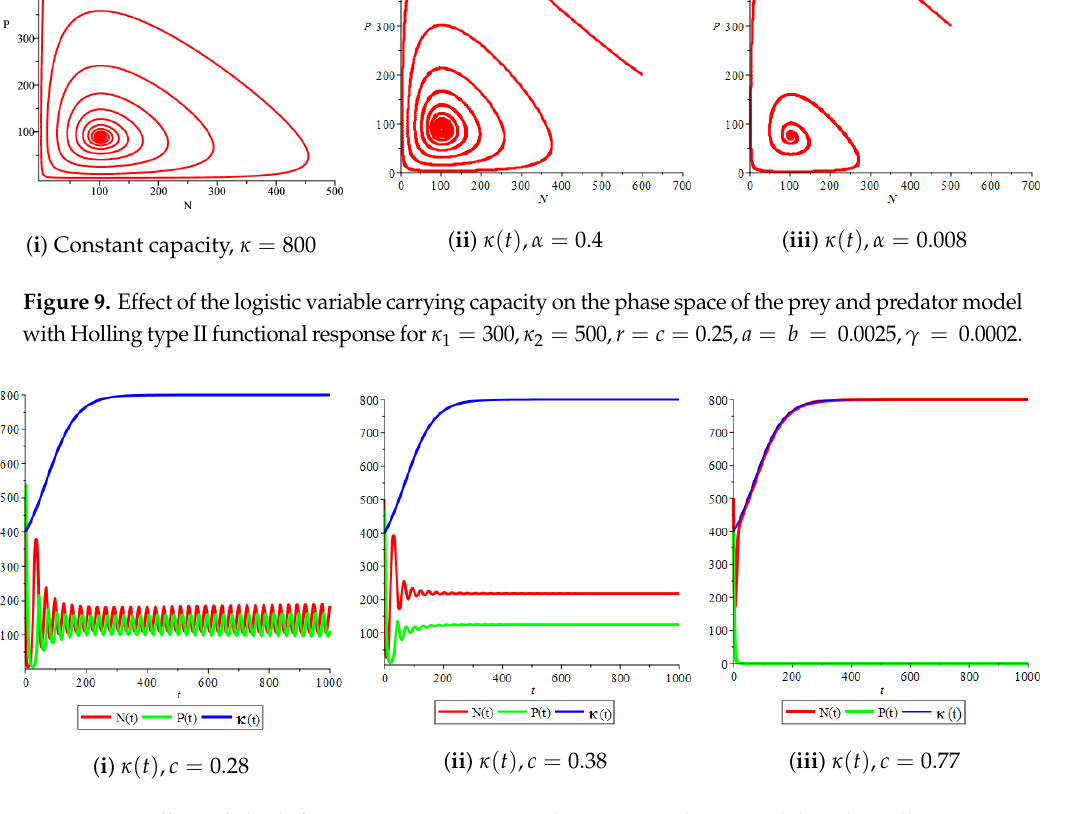
Figure 10. Effect of the bifurcation parameter on the prey–predator model with Holling type II functional response, κ 1 = 300, κ 2 = 500, r = 0.3, a = b = 0.0025, γ = 0.002, m = 0.2, α = 0.02.